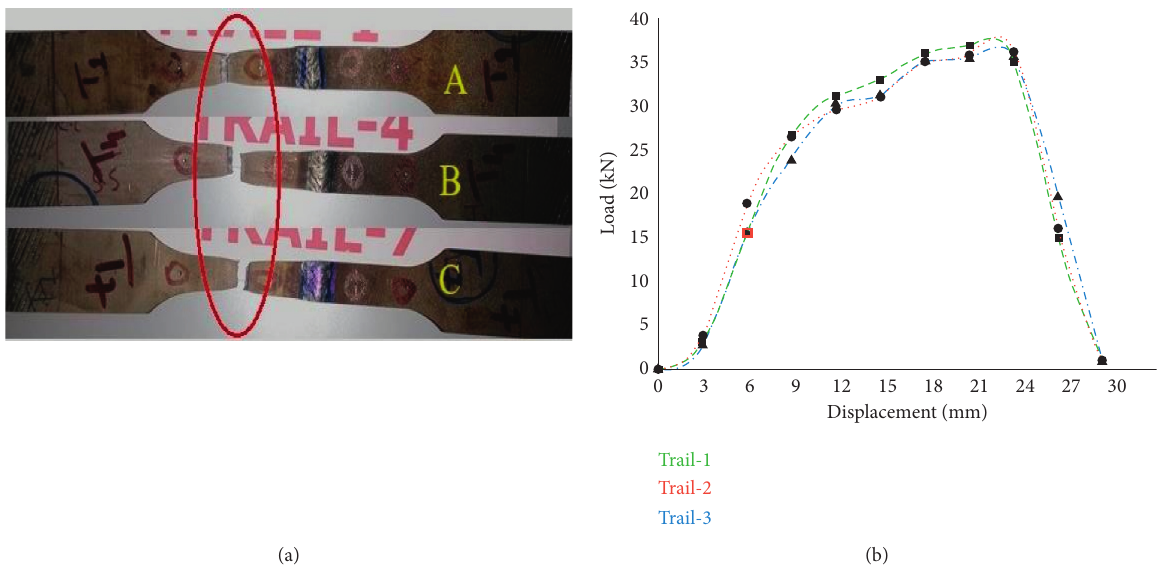
Figure 8: Specimens after machining prepared for tensile strength. (a) Fracture occurred at the parent metal of SS316L. (b) Load vs.